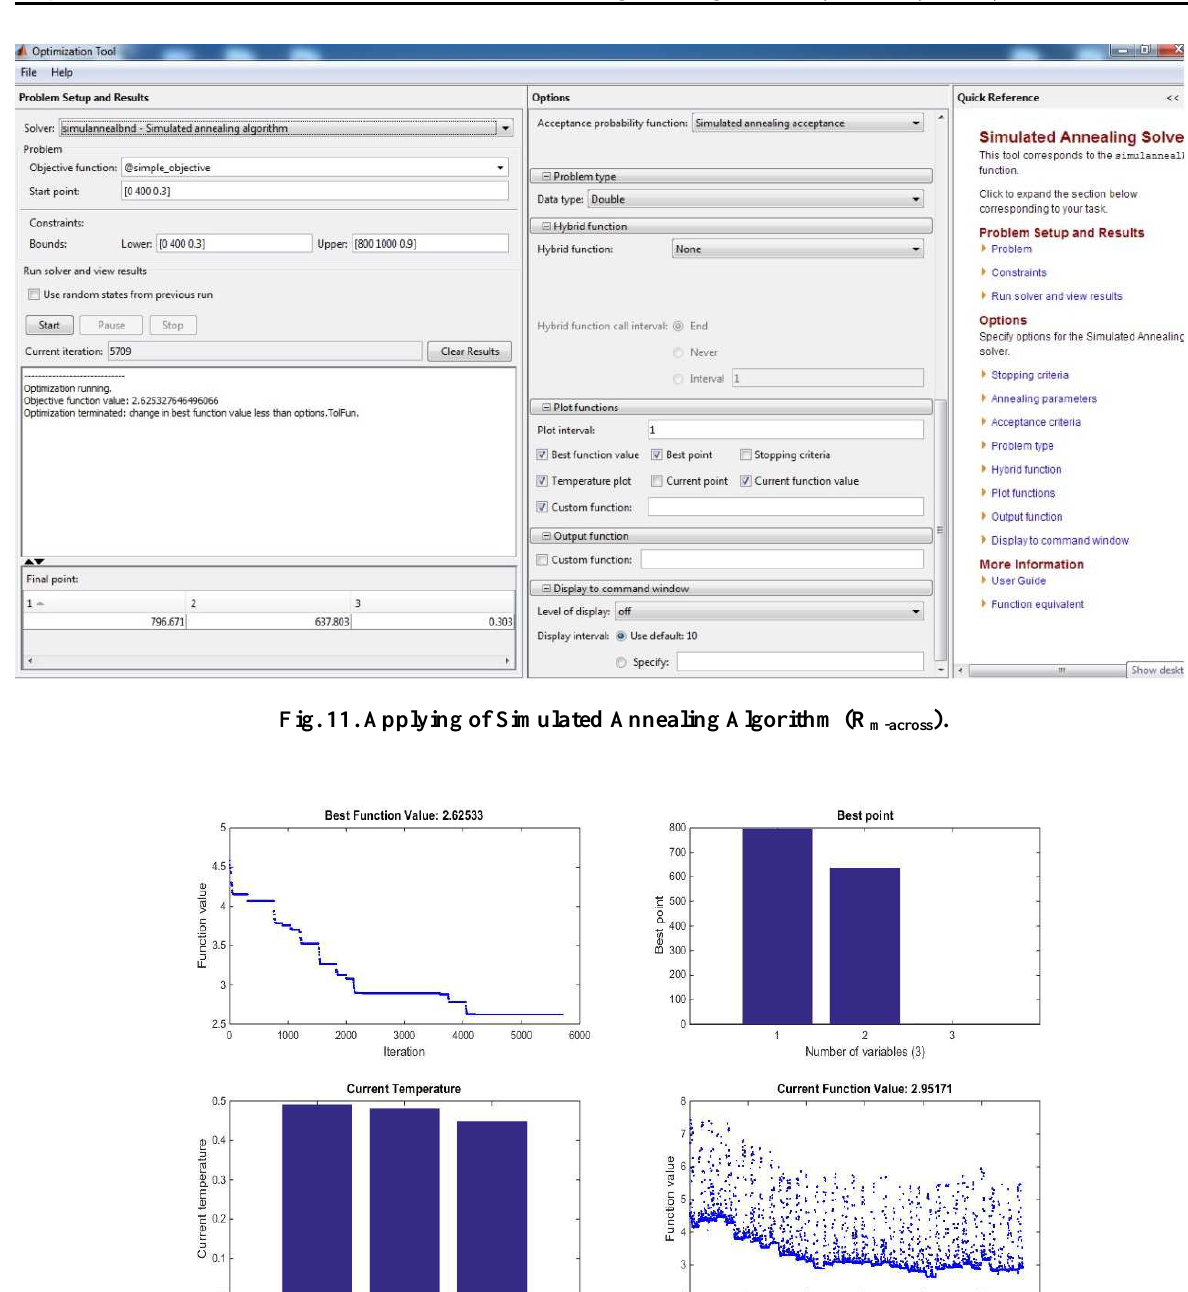
Fig.12. Performance of Simulated Annealing Algorithm (R